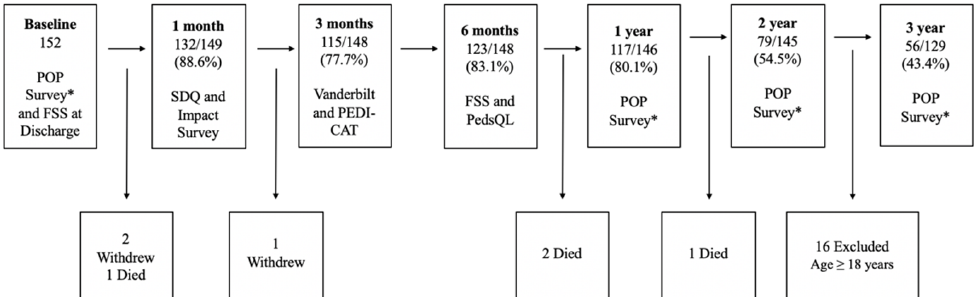
Figure 2. Cohort retention and follow-up among PICU survivors. * POP survey = impact survey, functional status scale (FSS), Pediatric Evaluation of Disability Inventory Computer Adaptive Test (PEDI-CAT), Pediatric Quality of Life Inventory TM (PedsQL), Strengths and Difficulties Questionnaire (SDQ), and Vanderbilt Assessment Scales for Attention Deficit-Hyperactivity Disorder (Vanderbilt); PEDI-CAT was not included at 1- and 2-year follow-up.